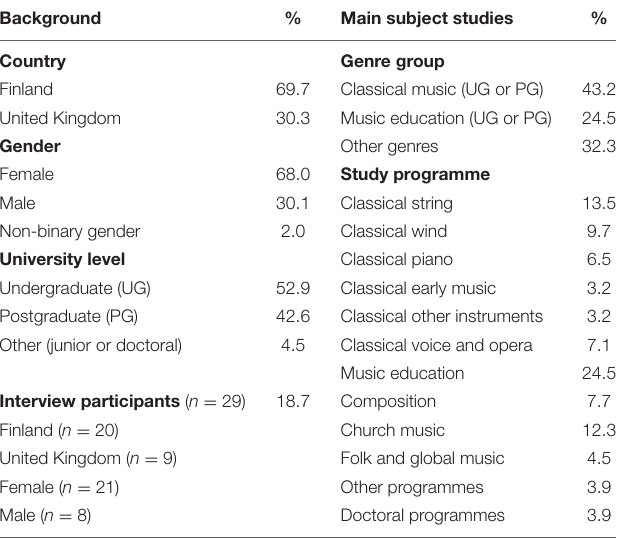
TABLE 1 | Demographic characteristics of all participants in the sample ( N = 155).